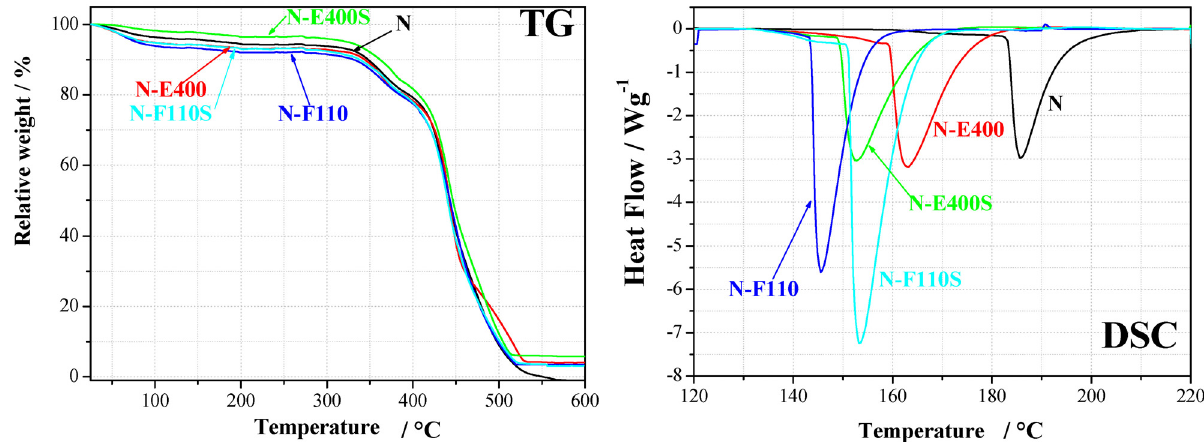
Figure 6. Thermal analysis results (TG and DSC) for the five